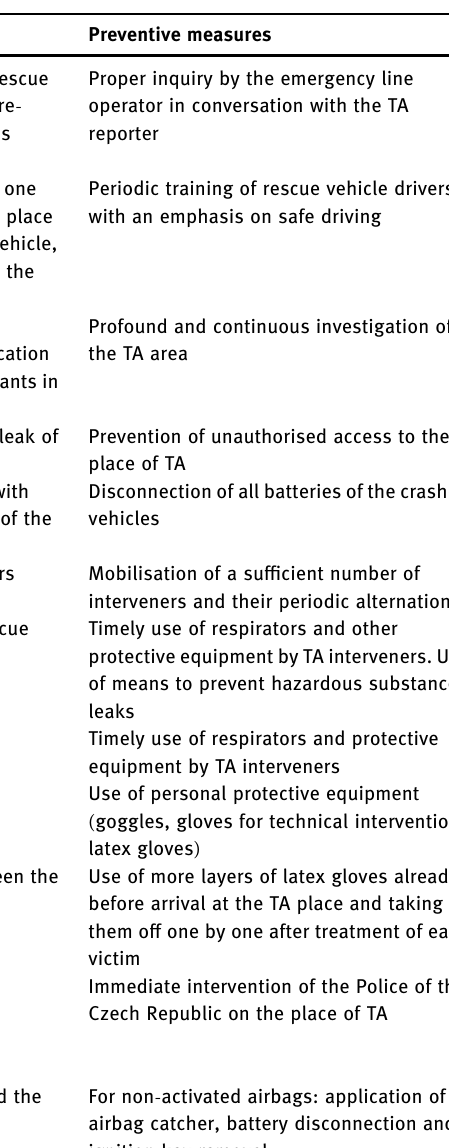
Table 5: Risk identi fi cation by What - if